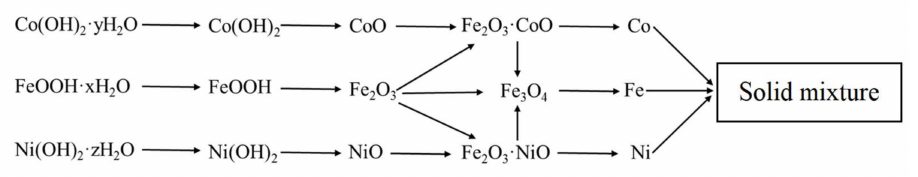
Figure 4. Scheme of phase formation in Fe–Co–Ni magnetic nanocomposites between 300–500 ◦